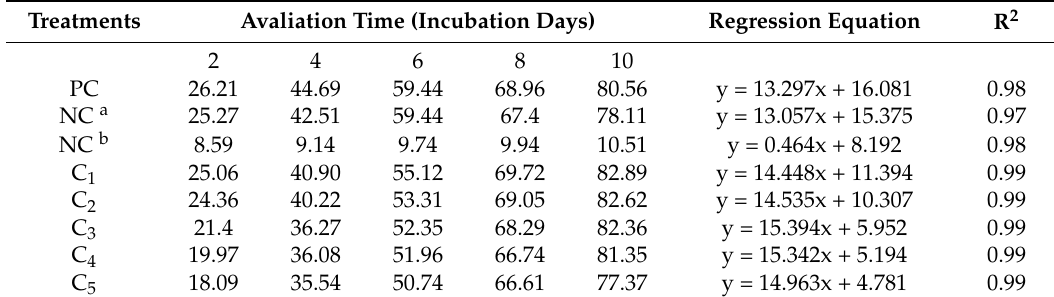
Table 1. Mean mycelial diameter (mm) of Curvularia lunata under different concentrations of the C. citratus essential oil.